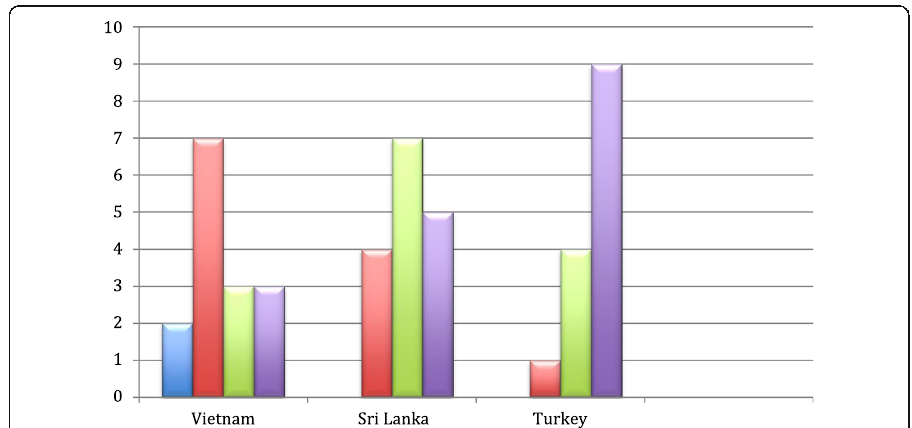
Fig. 1 Visits made to the heritage country. Column 1: No visits. Column 2: 1 – 2 visits. Column 3: 2 – 4 visits. Column 4: More than 4